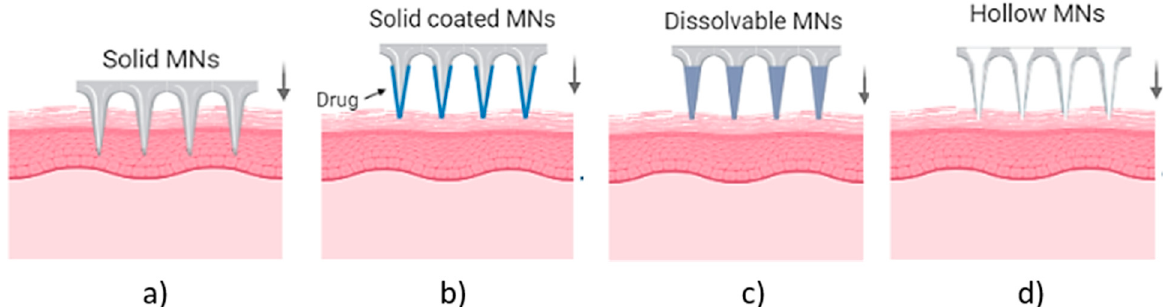
Figure 1. Types of MN array. ( a ) solid MNs, that require a transdermal patch for continuous drug administration after their insertion/removal, ( b ) coated, where the drug is coated around the needles, ( c ) hollow MNs for the creation of a path to administer the drug using conventional needles and ( d ) dissolvable that are filled with the drug and fully dissolved following skin insertion